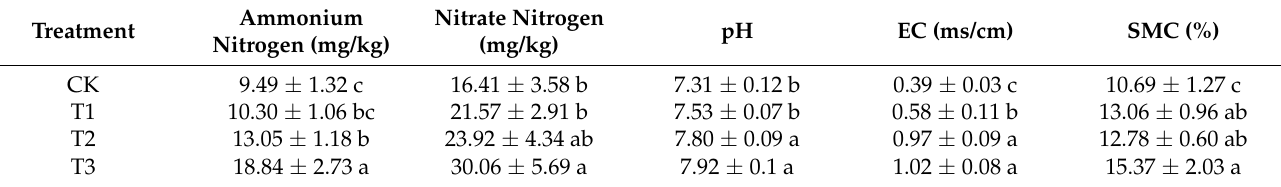
Table 4. Importance ordering and significance test of soil variables (Moss crusts).